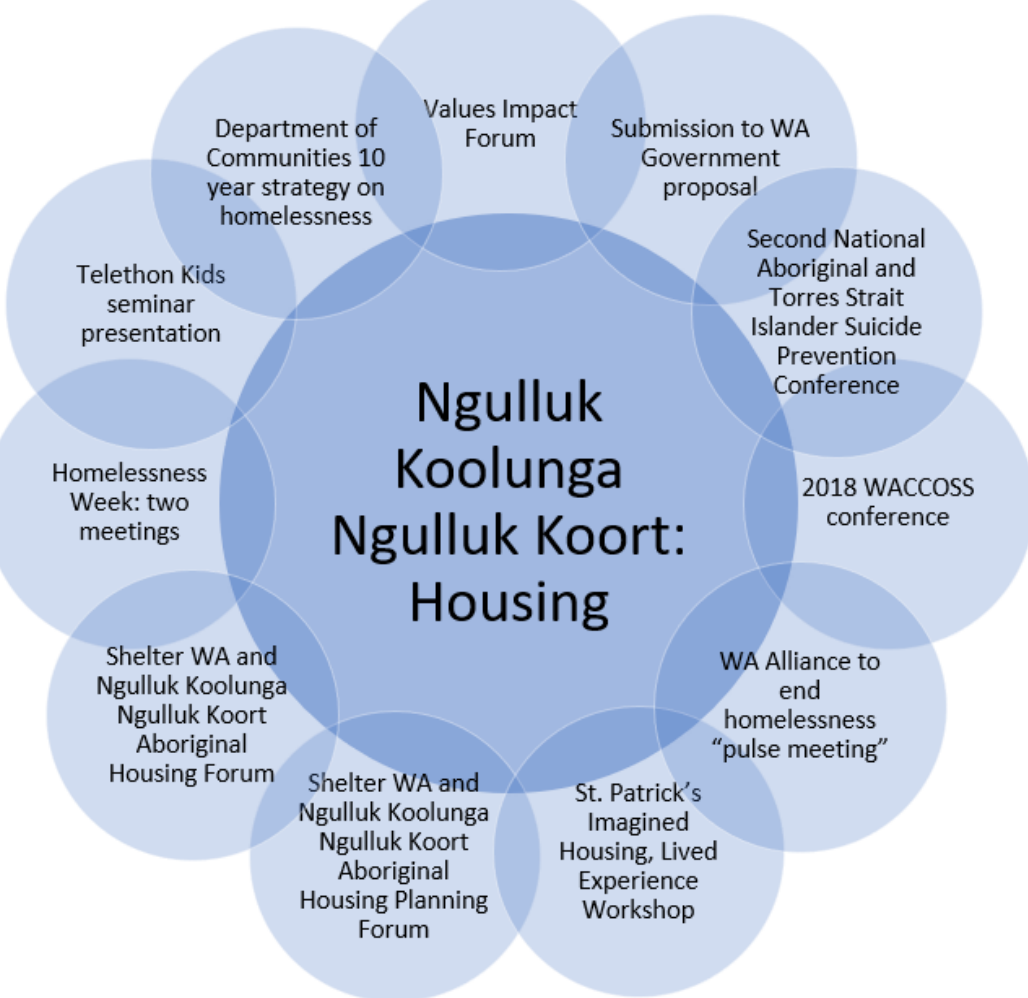
Figure 4. Housing and homelessness research translation activities (Reprinted with permission from